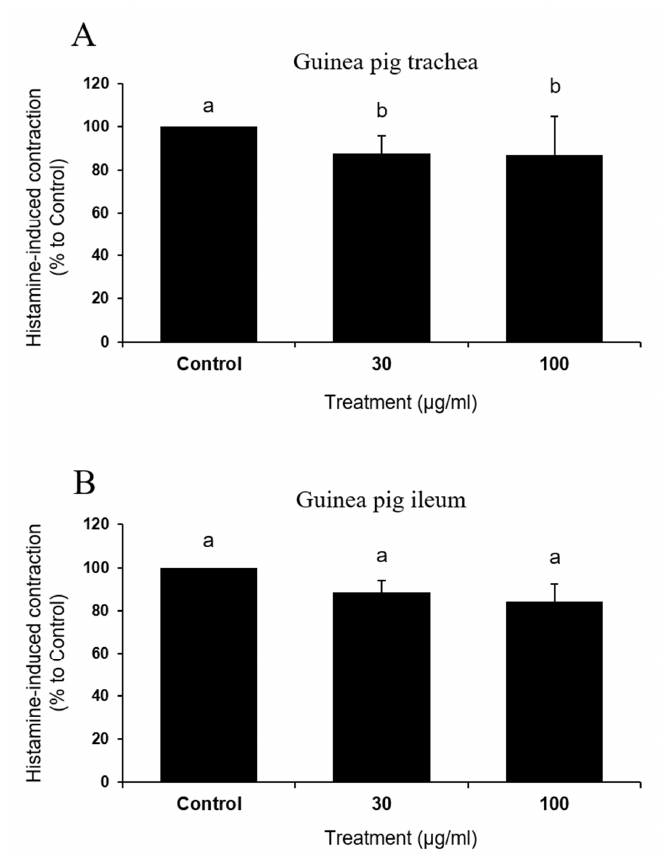
Figure 6. Effects of isoquercitrin (IQ) on histamine-induced muscle contractions. Histamine (1 μM)-induced muscle contraction in ( A ) trachea and ( B ) ileum tissues were measured ( n = 5 per group). DMSO was used as the control. Different alphabets on the bars denote significantly different means at p < 0.05. 3.6. IQ Stabilizes Mast Cells and Inhibits OVA-Stimulated Intracellular Calcium Release Since IQ did not protect muscles from histamine stimulation but did inhibit histamine release, we next evaluated its effect on intracellular calcium levels. As shown in Figure 7, positive control cromolyn sodium inhibited calcium depletion caused by PMA + A23187 in HMC-1 cells. Similar results were observed by pre-treatment with IQ, and in addition, both cromolyn sodium and IQ suppressed calcium influx in mast cells as well.